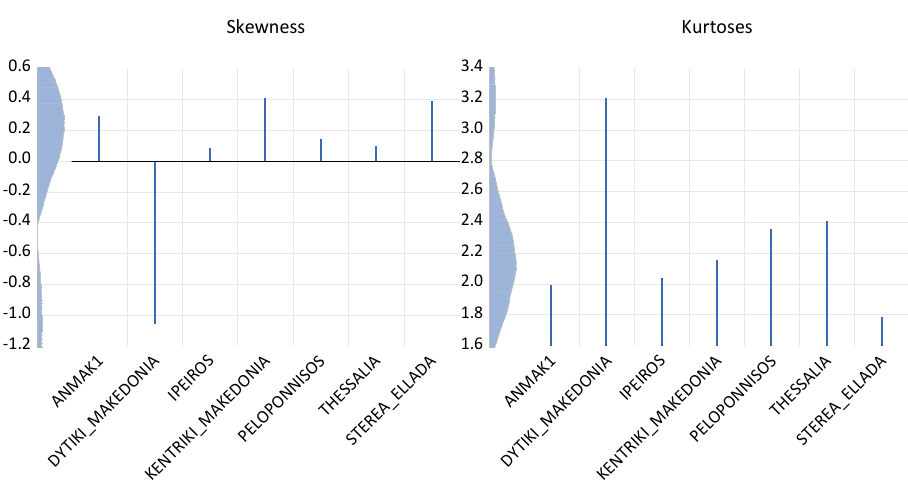
Figure 3. The skewness and the kurtosis of the variables employed in our analysis for the studied time period (Source: NSI, own data processing).